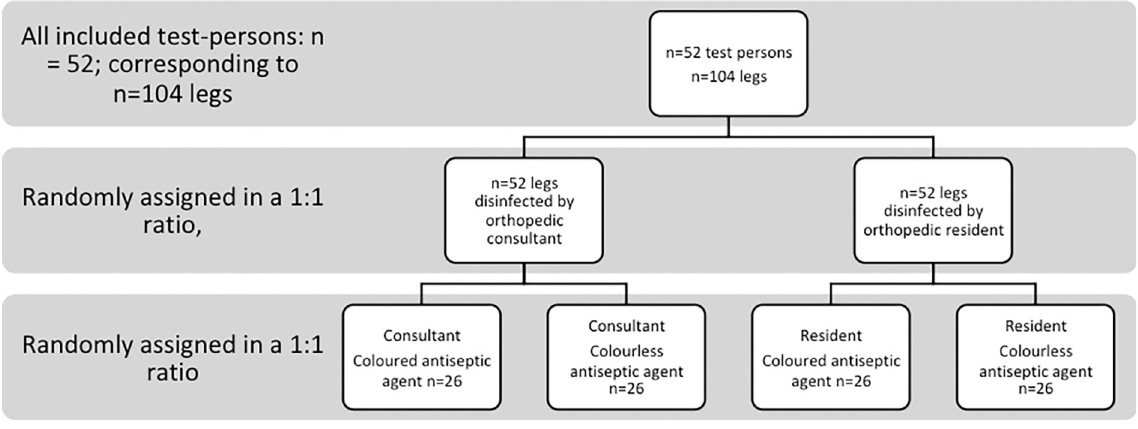
Fig 1. Randomization and treatment regime used in our study.